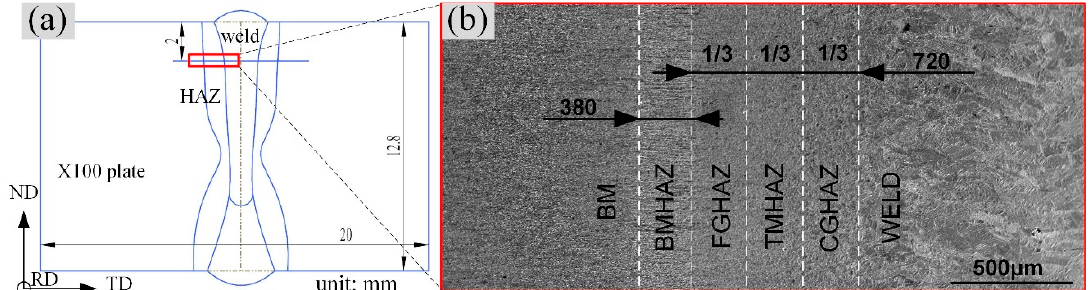
Figure 3. Components of the laser-welded joint in X100 pipeline steel: ( a ) shapes of the weld and heat- affected zone; ( b ) microstructural zones and sizes of the